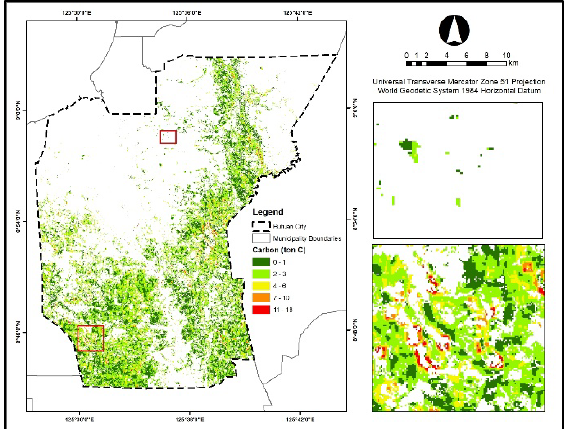
Figure 8. Scatter plot between calculated Carbon Stock and predicted Carbon Stock of the validation plots. Figure 6. Carbon Stock Map of Falcata Plantations in Butuan City.